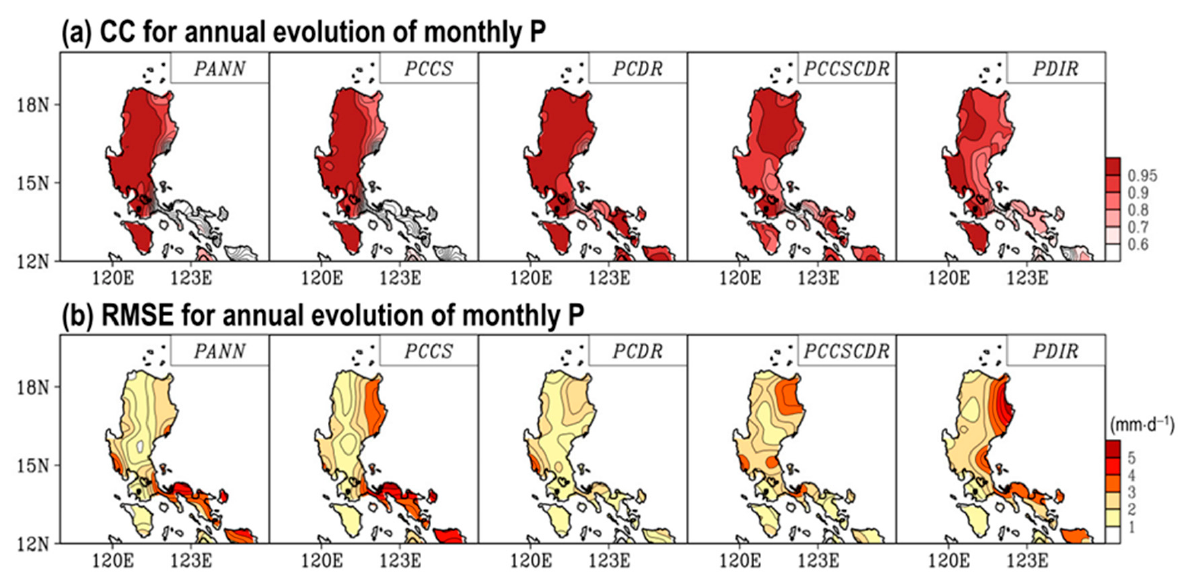
Figure 5. ( a ) Grid-to-grid CC between the satellite precipitation products and APHRO for the annual